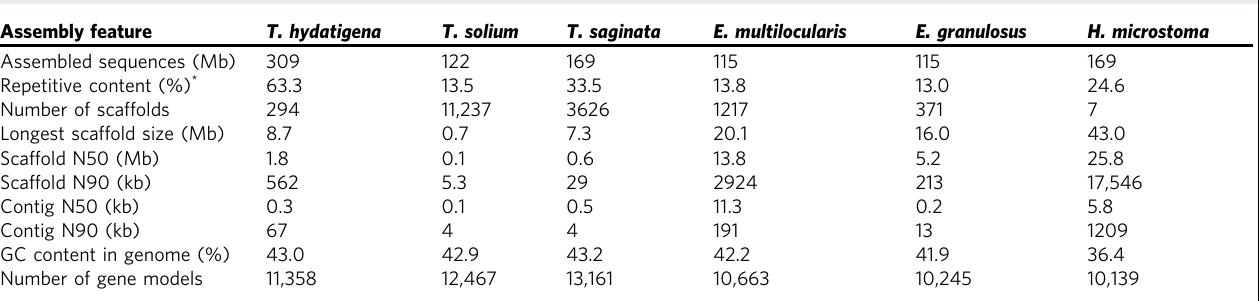
Table 1 Genomic features of T. hydatigena in comparison with other tapeworms. Assembly